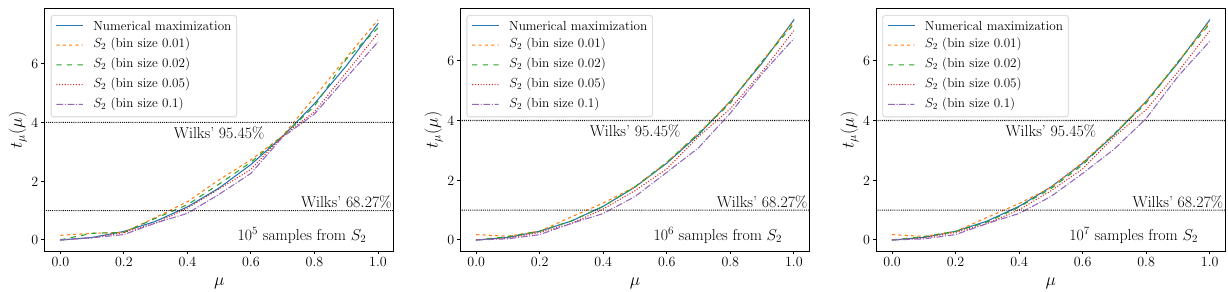
Fig. 7 Comparison of the t μ test-statistics computed using numerical maximisation of Eq. (17) and using a variable sample size from S 2 . We show the result obtained searching from the maximum by usind differ-